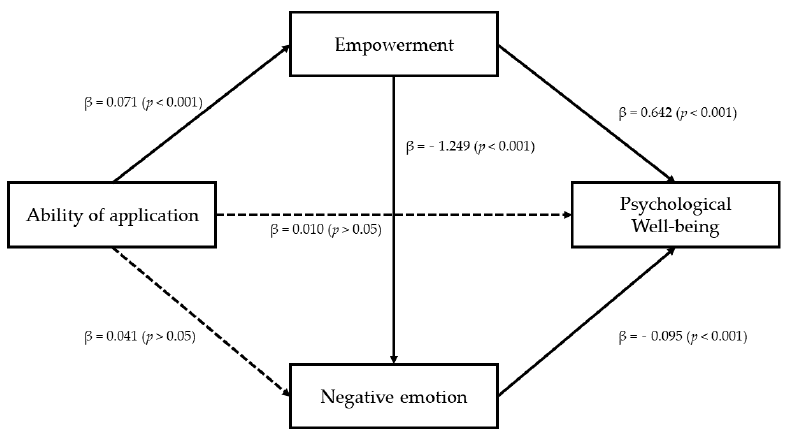
Figure 1. The result of verification of the double mediating effect of empowerment and negative emotion.